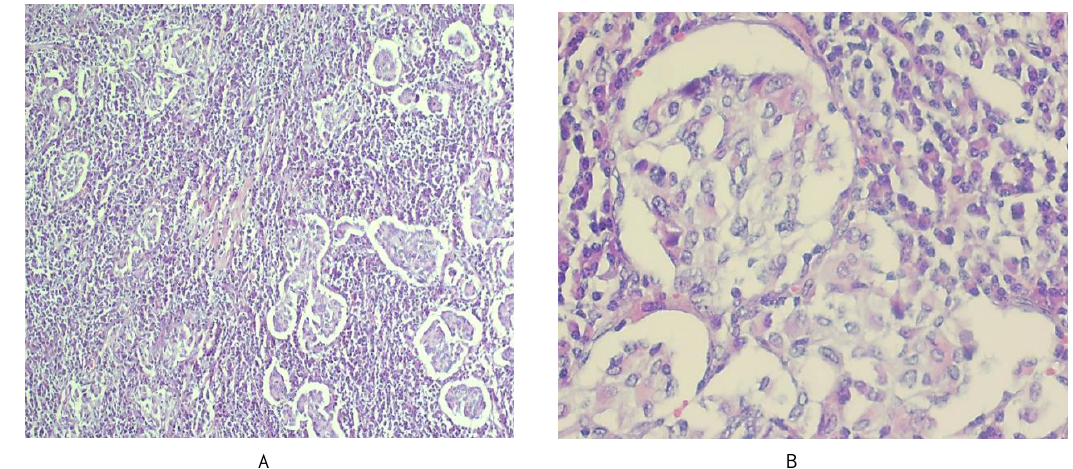
Fig. 2. A. (hematoxylin-eosin, magnification 100X), B. (hematoxylin-eosin, magnification 400X), section shows nests of the cells with eosinophilic cytoplasm surrounded by sustentacular cells in a dense lymphoplasmacytic